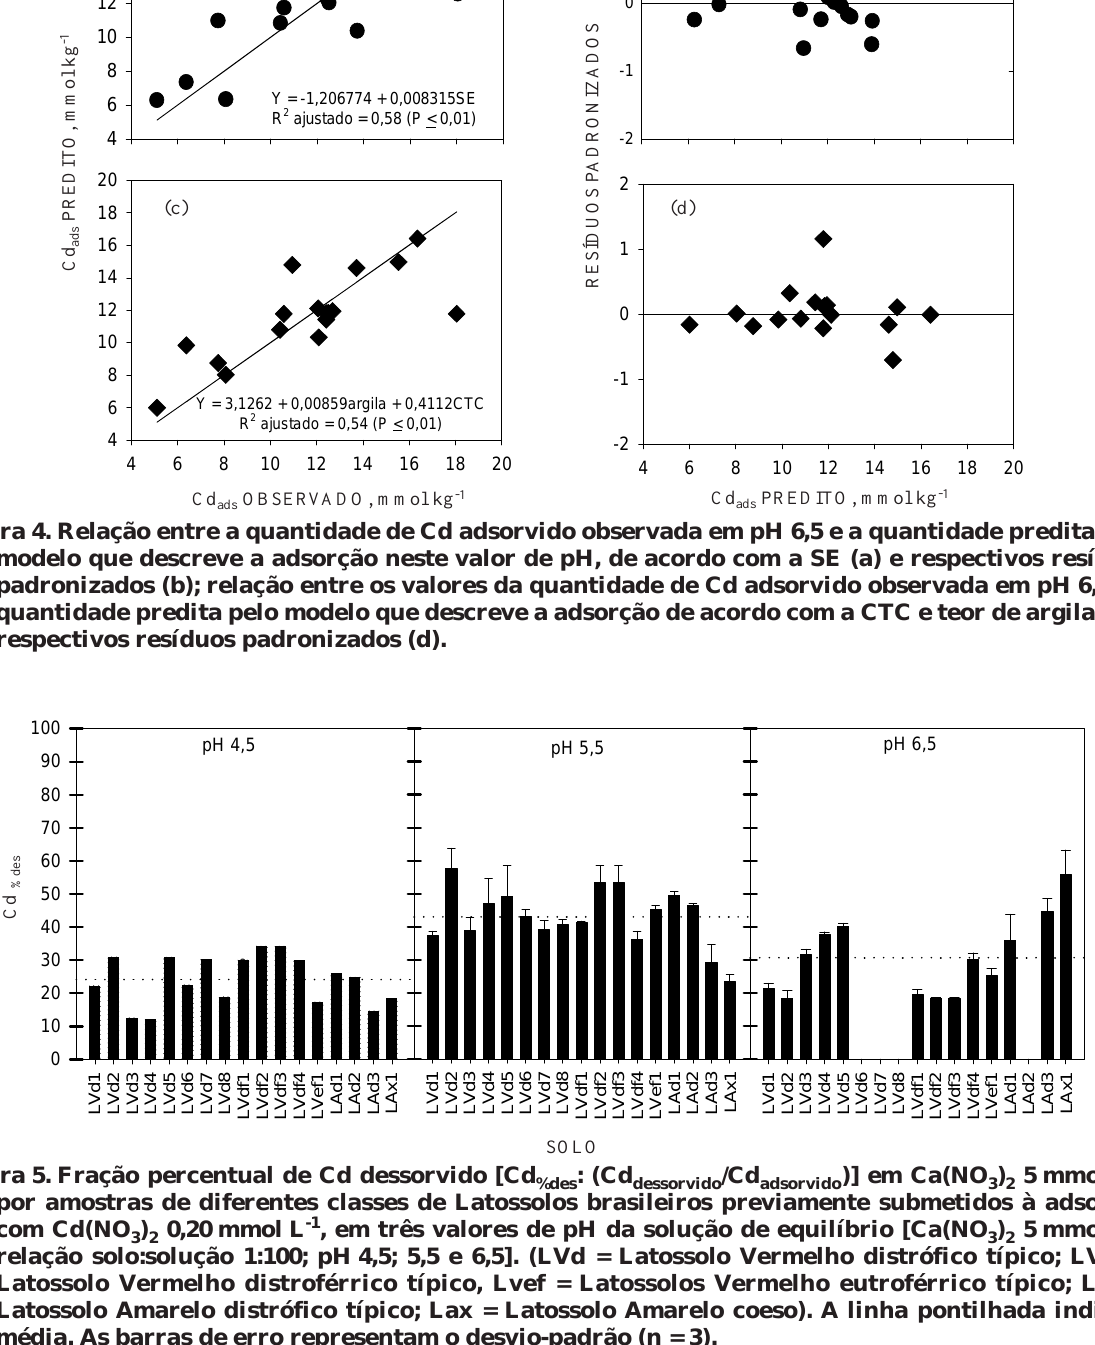
: (Cd /Cd )] em Ca(NO ) 5 mmol L -1 , %des dessorvido adsorvido 3 2 ) 5 mmol L -1 ; 3 2